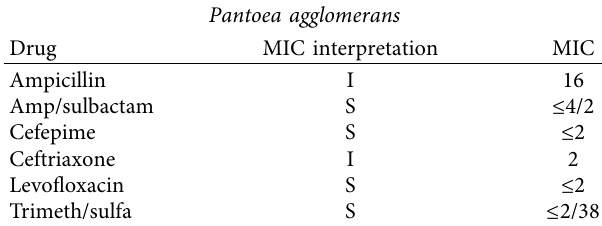
Table 1: Microorganism susceptibility